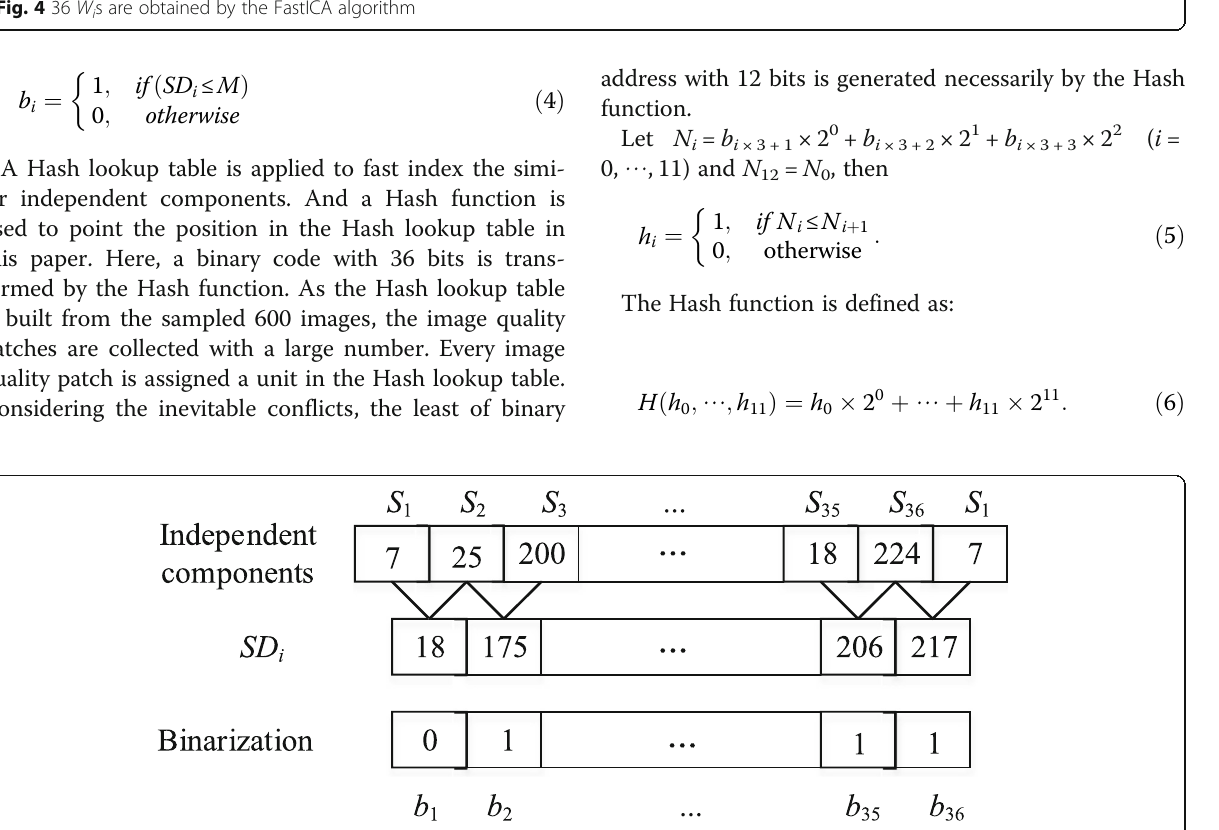
Fig. 5 The binarization process of the independent components coefficients Si